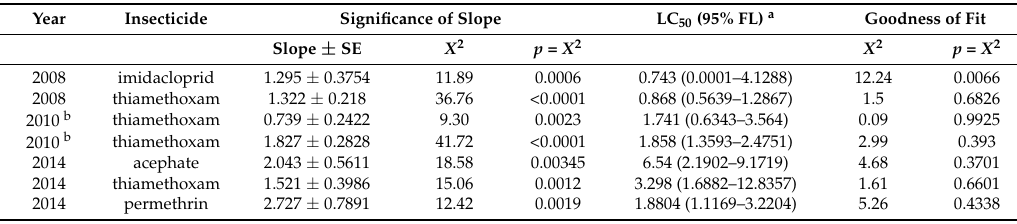
Table 1. Concentration-response regressions for insects collected as a reference control from Crossett, AR, during 2008–2014.